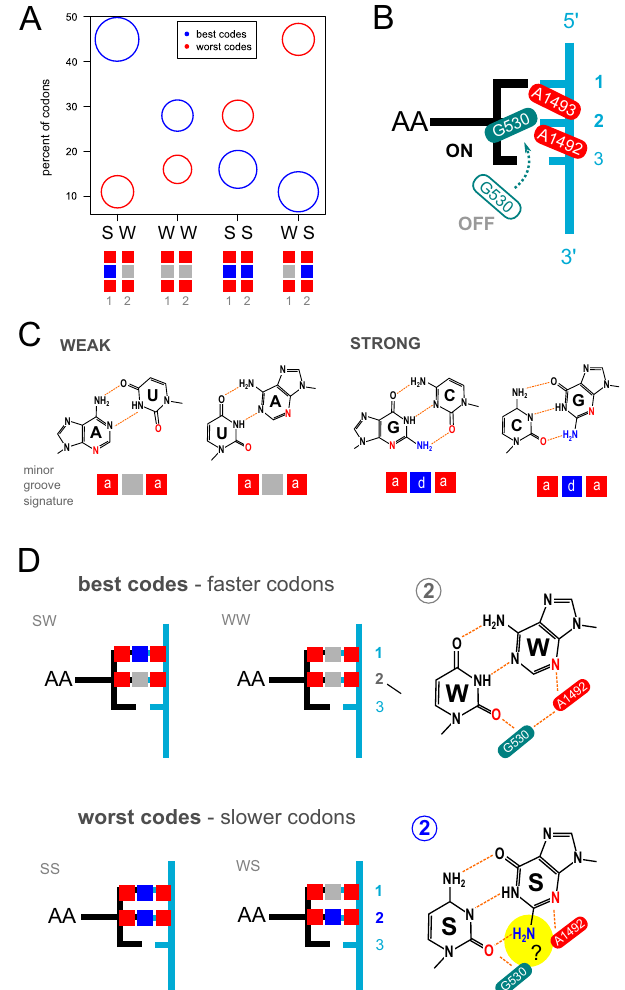
Figure 8. Correlation of circular code properties with the S/W character of the codon hint at the decoding mechanism dynamics. ( A ) Comparison of codon composition of best codes (blue) and worst codes (red) according to the S/W chemical dichotomy of the first two nucleotides of the codon. The area of the bubbles is proportional to the average codon influence. Codons of the kind SWN and WWN identify the best codes, i.e. those associated to a higher expression level and coverage. Conversely, codons of the kind SSN and WSN characterize the codes having lower expression level and coverage. Boxed rectangles depict H-bond pattern formation in the minor groove of the codon-anticodon minihelix in positions 1 and 2 (see panel C for molecular details). ( B ) Model for the cognate codon-anticodon recognition in the minor groove of the decoding center (A site) of the ribosome; mRNA (light blue), aminoacyl-tRNA (black), universally conserved A1492 and A1493 nucleotides forming A-minor motif (red); universally conserved G530 nucleotide involved in latch closure and H-bonding with A1492 and A1493 (petrol green); numbers denote the nucleotide position of the codon. ( C ) Molecular detail of all possible cognate Watson-Crick base pairs. The minor grove locates beneath each pair. Notice that W–W (A–U and U–A, respectively) and S–S (G–C and C–G) display the same signature of H-bond acceptors (a, red) and donors (d, blue). ( D ) Projection of the H-bond acceptor and donor signatures on the decoding center model. Faster codons (more abundant in better codes) lack the central H-bond donor in the second nucleotide of the codon (highlighted in yellow), which characterize the slowest codons (more frequent in worst codes). Note that the keto-amino (KM) transformation, invariably leading from the best to the worst code in each equivalence class, always transforms a W base in S and